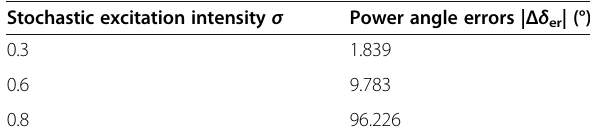
Table 3 Power angle error when excitation intensity is greater